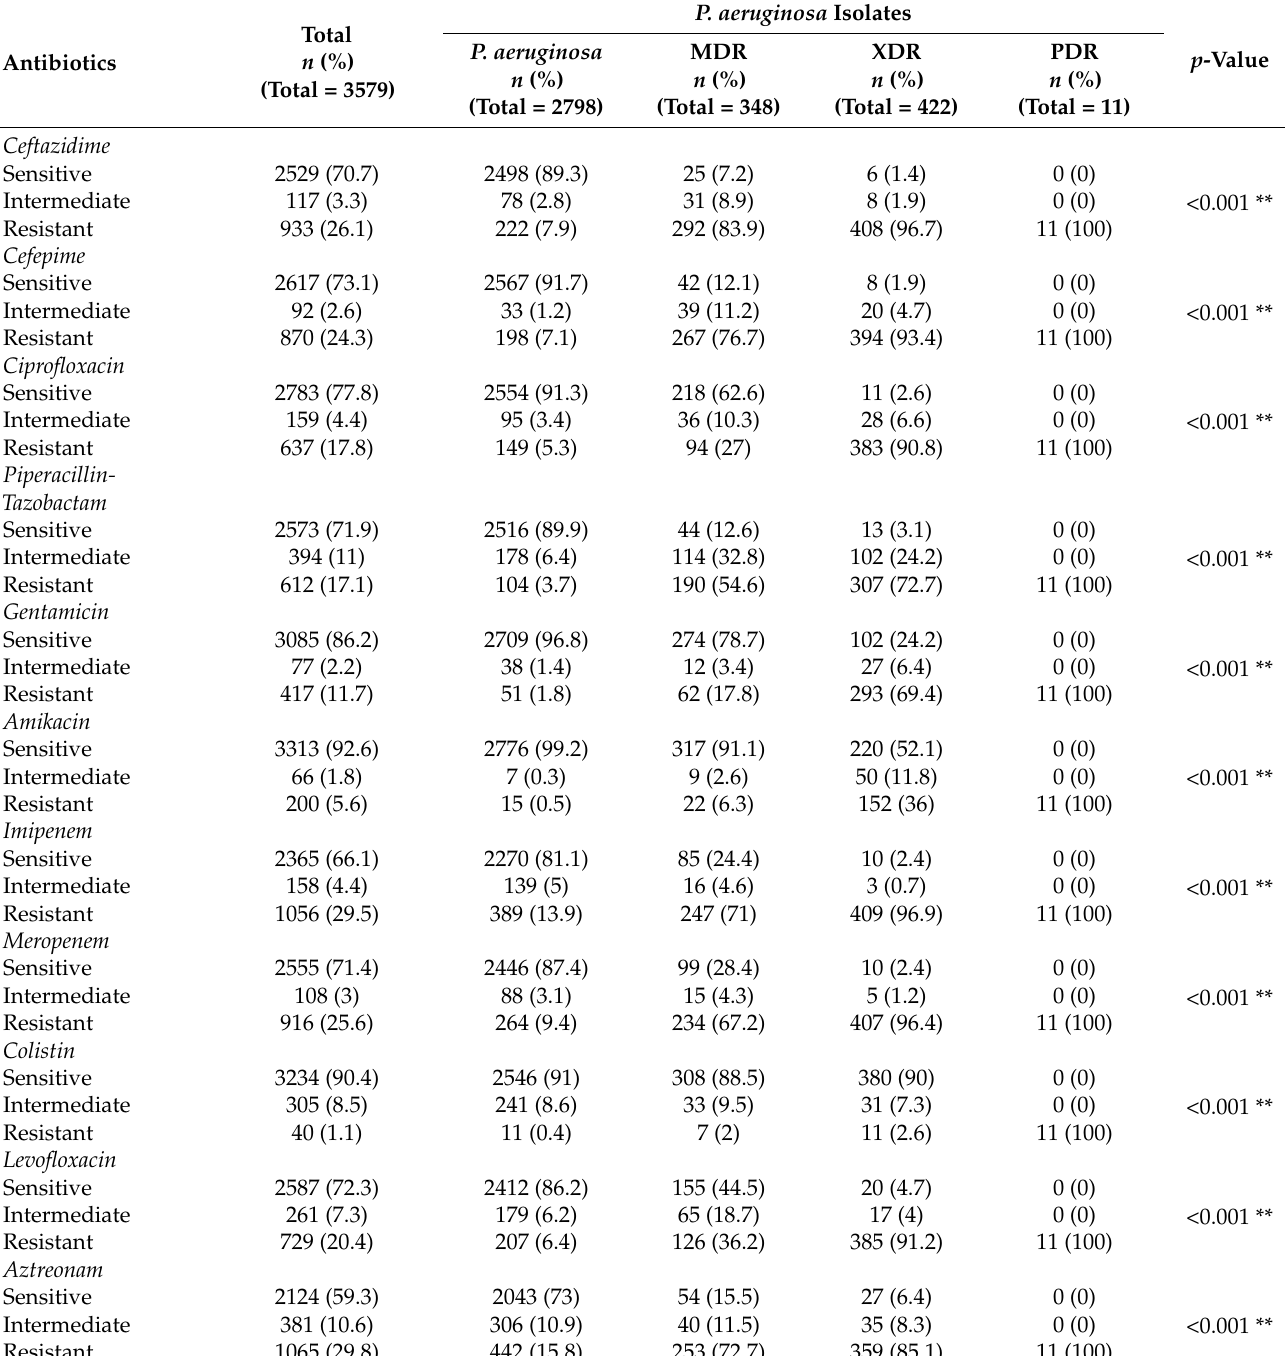
Table 2. Comparison of antimicrobial susceptibility among multi-resistant P. aeruginosa